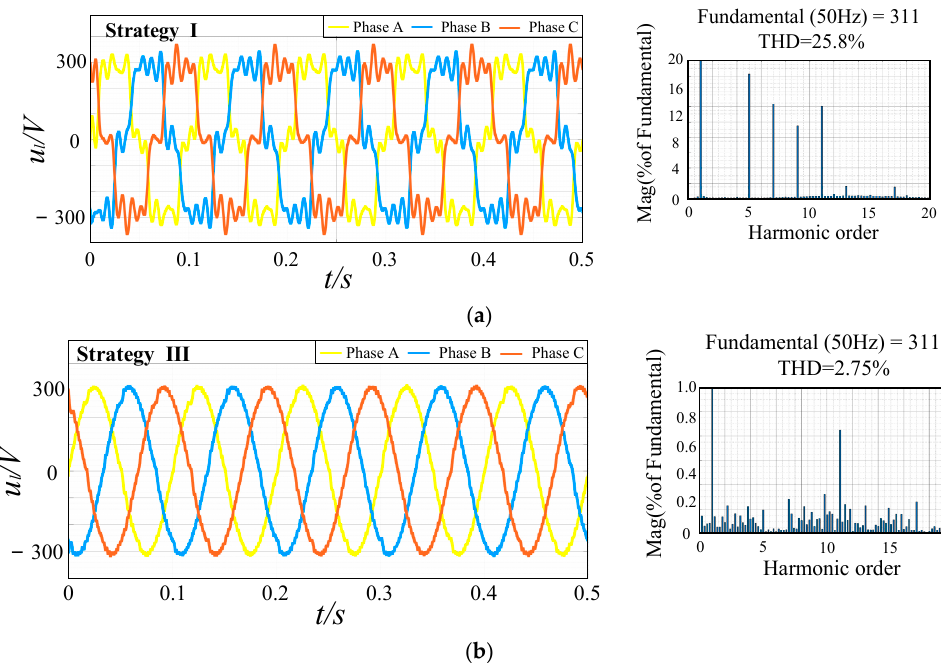
Figure 13. Load voltage after compensation of harmonics of different frequencies. ( a ) Load voltage after compensation of the 9th and 11th harmonics via Strategy I; ( b ) load voltage after compensation of the 9th and 11th harmonics via Strategy III.